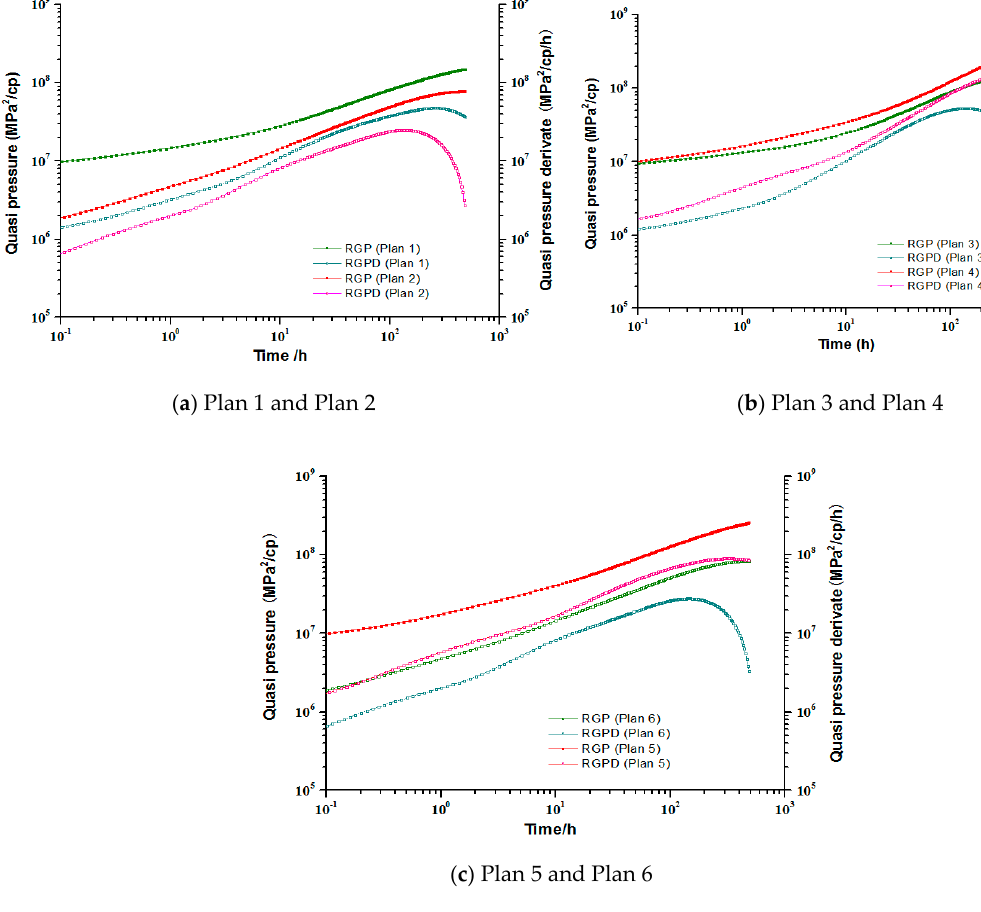
Figure 8. Double logarithmic curve of L2 well recovery pseudo pressure of each plan.